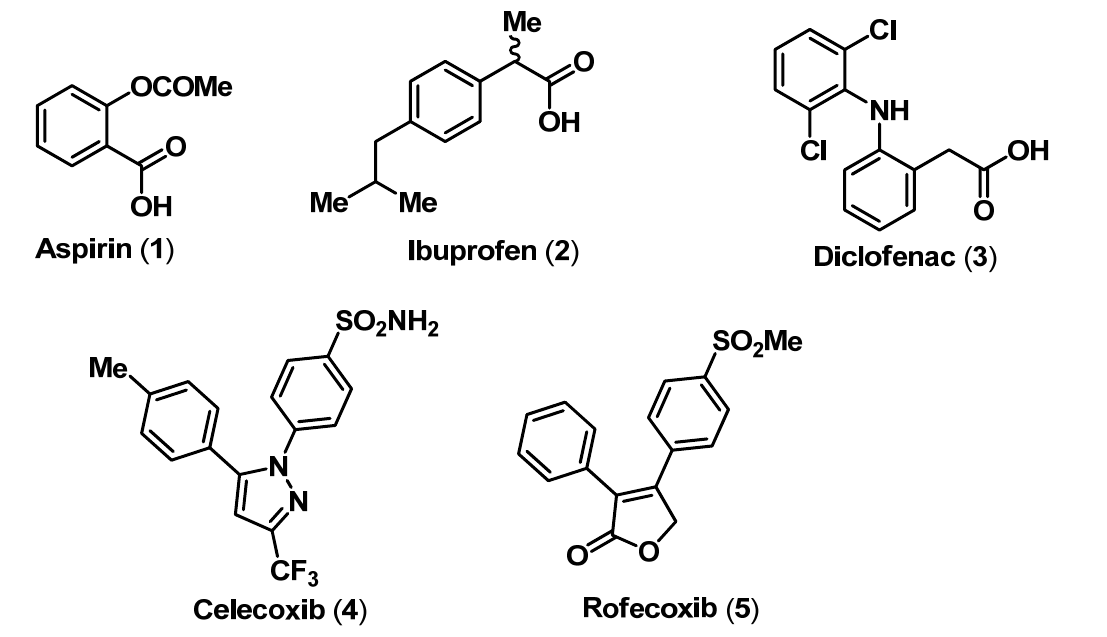
Figure 1. Chemical structures of some nonselective and selective COX